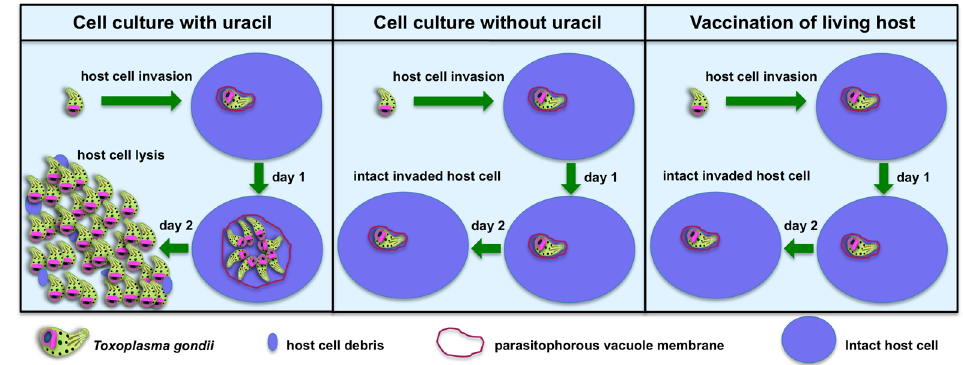
Fig 1. Nonreplicating Toxoplasma uracil auxotrophs (NRTUAs) do not replicate in living host animals. Left panel: Toxoplasma NRTUAs invadehost cells in vitro and replicate normally if the nutrient uracil is added to the culture medium. Center panel: Toxoplasma NRTUAs invadehost cells in vitro but do not replicatein the absenceof uracil supplementation. Right panel: Mammalian hosts have extremelylow uracil concentrations becausethey do not express the uracil phosphoribosyltransferase enzyme, and therefore, pyrimidinesalvage instead occurs through nucleosidekinasesthat salvagethe nucleoside uridineinto uridine 5 0 -monophosphate (UMP) [17]. In living hosts, Toxoplasma NRTUAs invadehost cells but do not replicate becausethere is insufficienturacil to support replication.